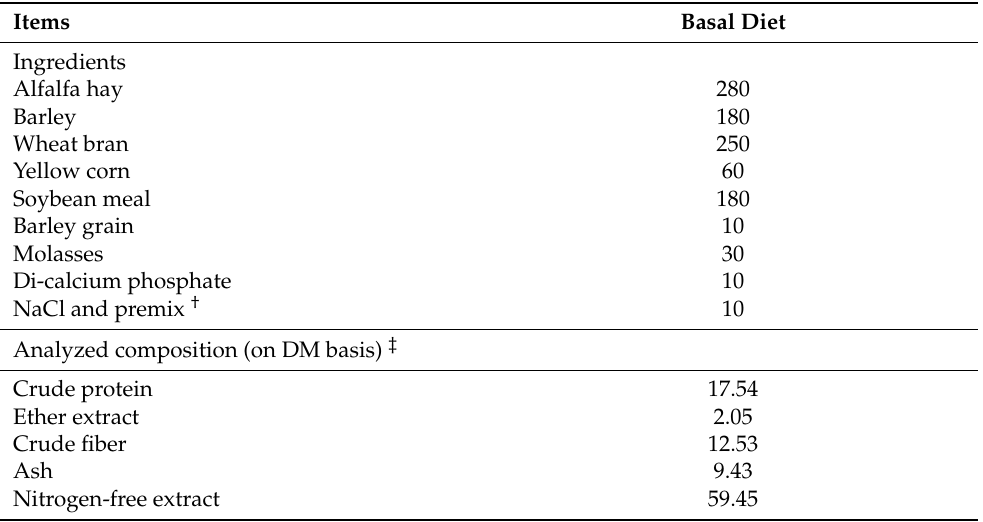
Table 1. Basal diet ingredients and chemical analysis (expressed as g/kg dry matter,